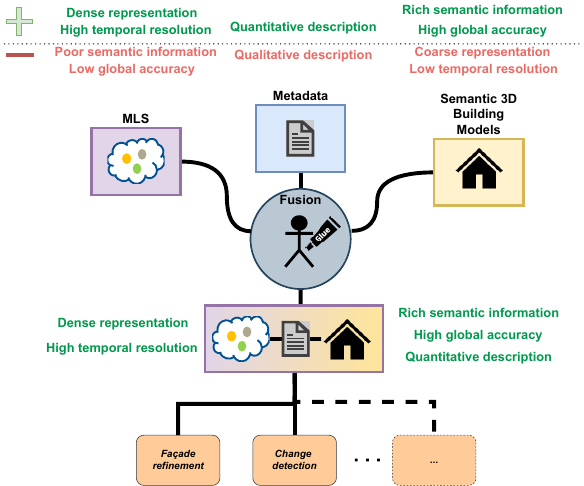
Figure 1. The fusion supported by expert knowledge maximizes the potential of semantic 3D building models and MLS point clouds in a myriad of